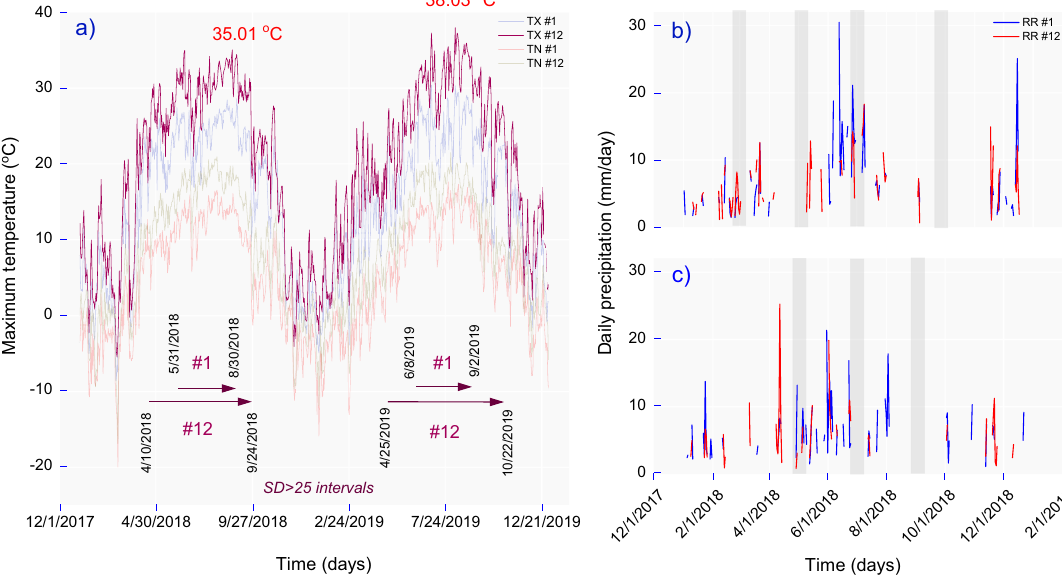
Fig. 1 Climate data for the extreme sites Cornetu Lake (#1) and Danube River — upstream of the Olt River (#12). a digital daily minimum (TN) and maximum (TX) temperature; b the sum of daily precipitation (RR) for sites #1 and #12 in 2018, and c the sum of daily precipitation (RR) for sites #1 and #12 in 2019; dark bars indicate the sampling periods; SD summer days. The climate data were extracted from European Climate Assessment and Dataset (ECA&D) database